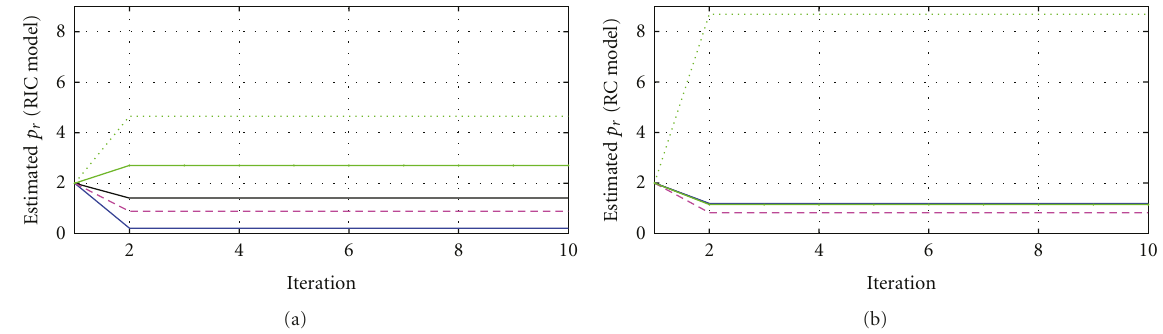
Figure 6: Estimated measurement noise shape factor produced by representative COPD patient (a) for RIC model and (b) for nonlinear RC model.